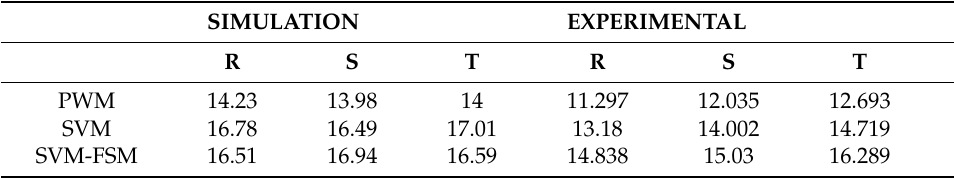
Figure 19. Laboratory setup. Table 5. Vrms (V), f sw = 2000 Hz.